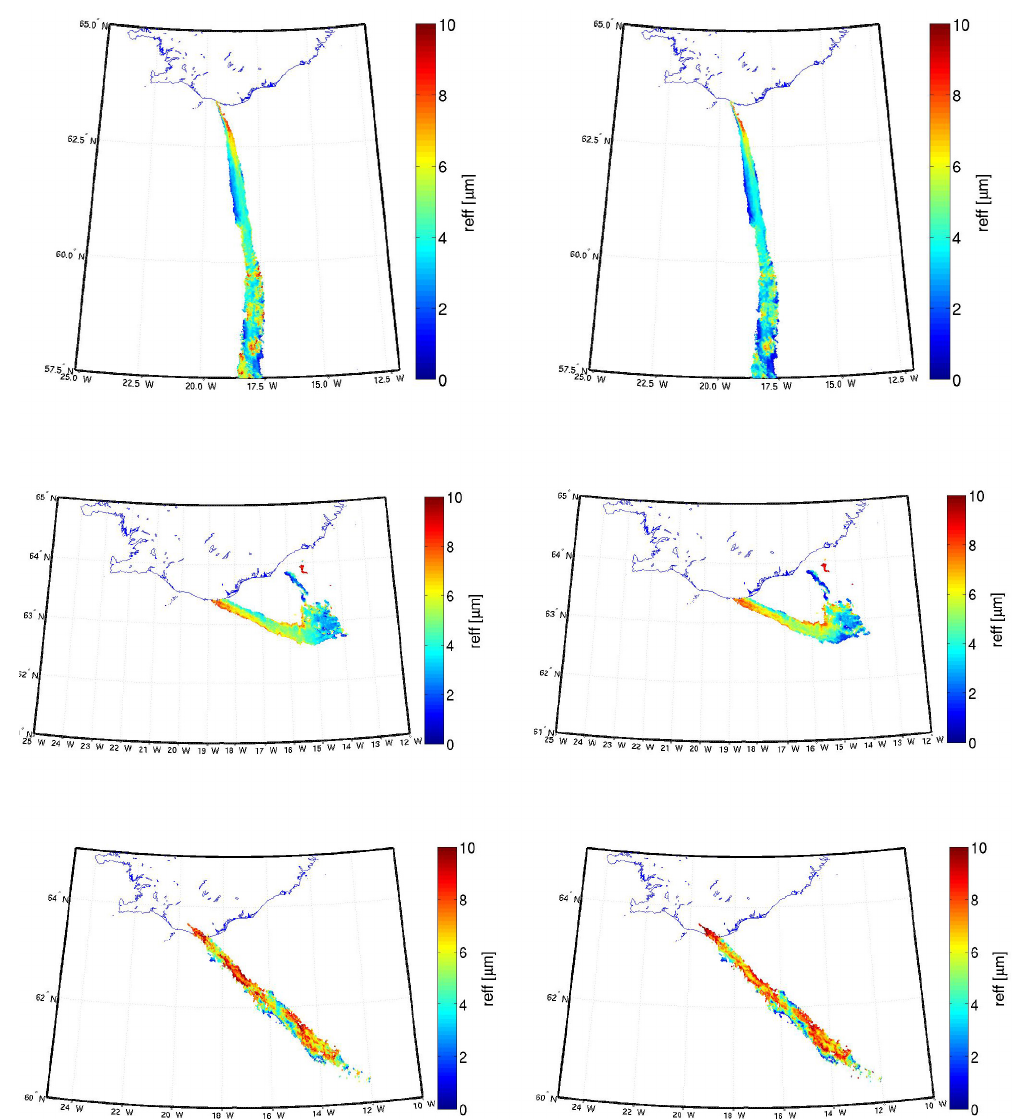
Figure 18. r eff maps: top, 11 May 2010; middle, 12 May 2010; bottom, 16 May 2010. Left: target retrieval; right: retrieval from pruned neural